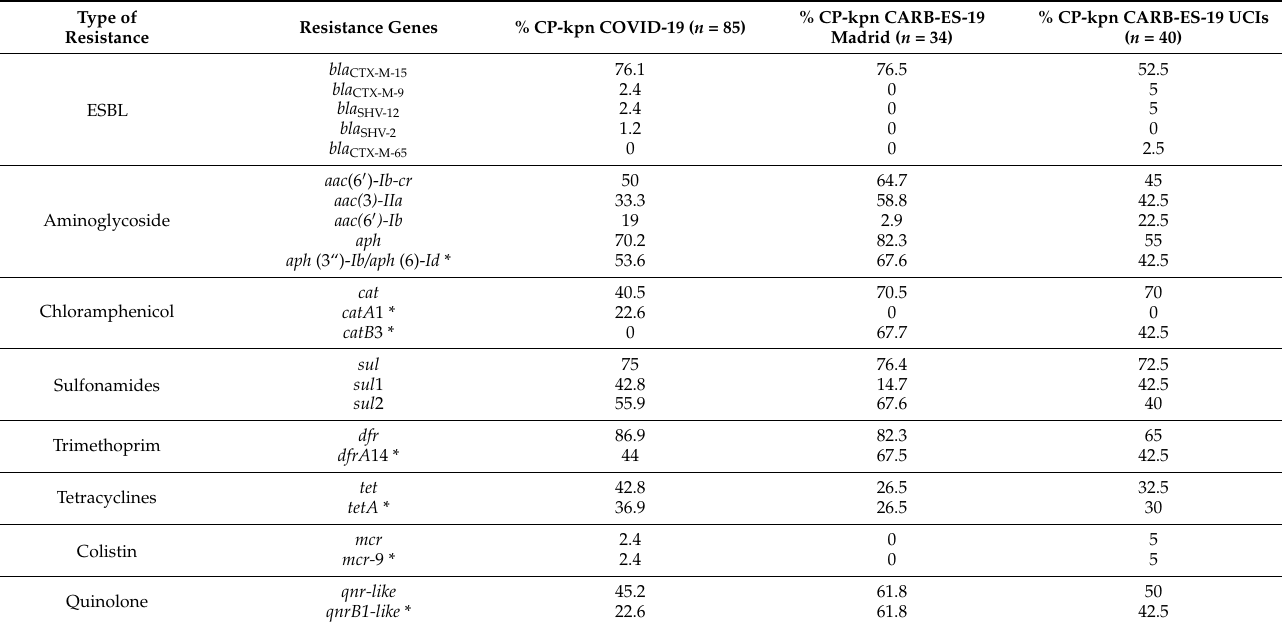
Table 4. Identification of the most frequent antibiotic resistance genes found in carbapenemase- producing K. pneumoniae from COVID-19 patients in Madrid ICUs (CP-Kpn COVID-19) versus two groups of prepandemic isolates (CARB-ES-19 project) from patients in Madrid (CP-Kpn Madrid- CARB-ES-19) and from Spanish patients admitted in ICUs (CP-Kpn